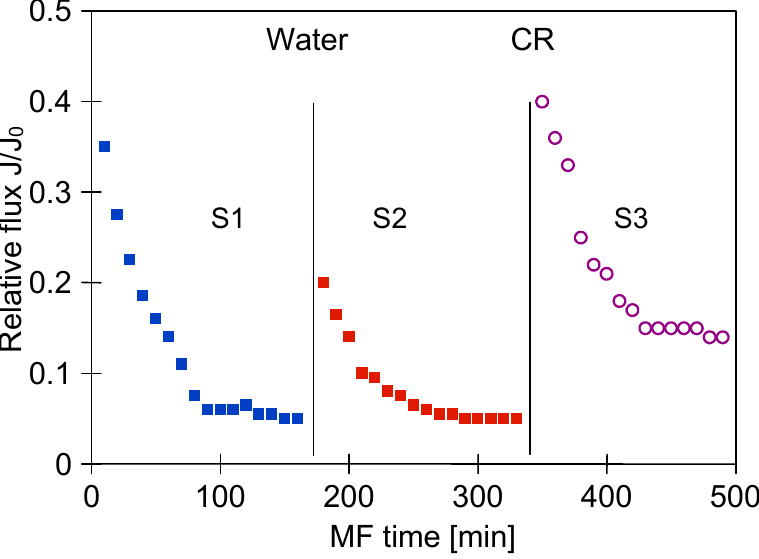
Figure 17. Changes in relative permeate flux during the long-term MF process of 1,3-PD fermentation broth with Lactobacillus casei with periodically cleaning the module. Module M2, TMP = 0.05 MPa, V F = 1.5 m/s, CR—chemical cleaning (NaOH).